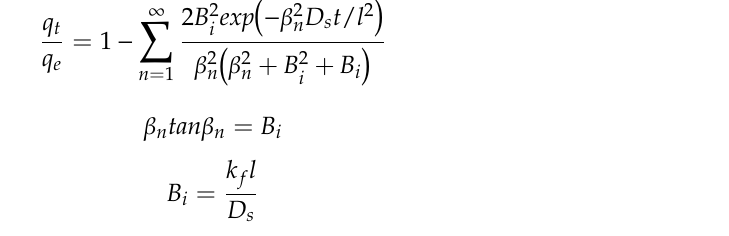
Table 2. Parameters obtained by non-linear least-squares adjustment of Equation (3).